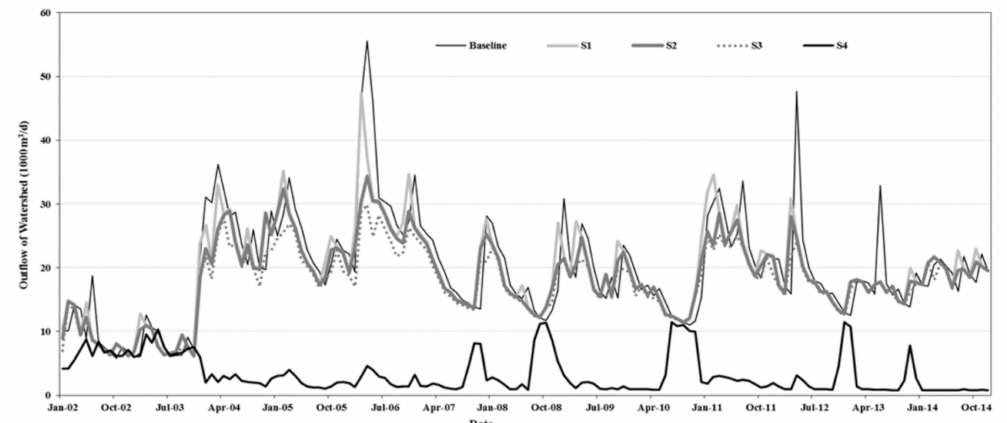
Figure 9. The monthly outflow of the Heeia Watershed for different scenarios of irrigation management. S1 = Scenario one (initial minimum streamflow); S2 = Scenario two (decrease 50% of minimum streamflow); S3 = Scenario three (decrease 75% of minimum streamflow); S4 = Scenario four (decrease 90% of minimum